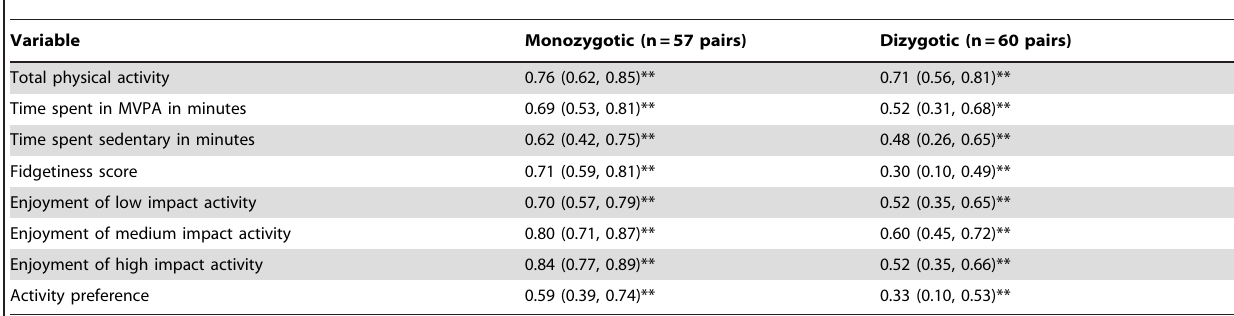
Table 2. Intraclass correlations for physical activity